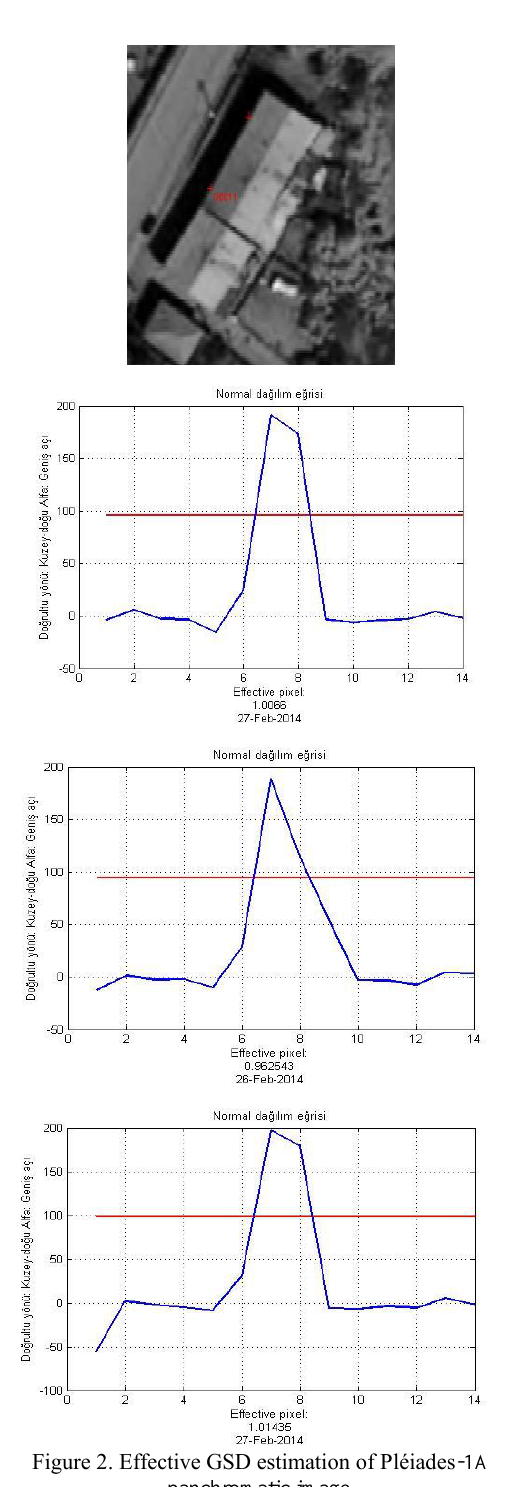
Figure 2. Effective GSD estimation of Pléiades-1A panchromatic